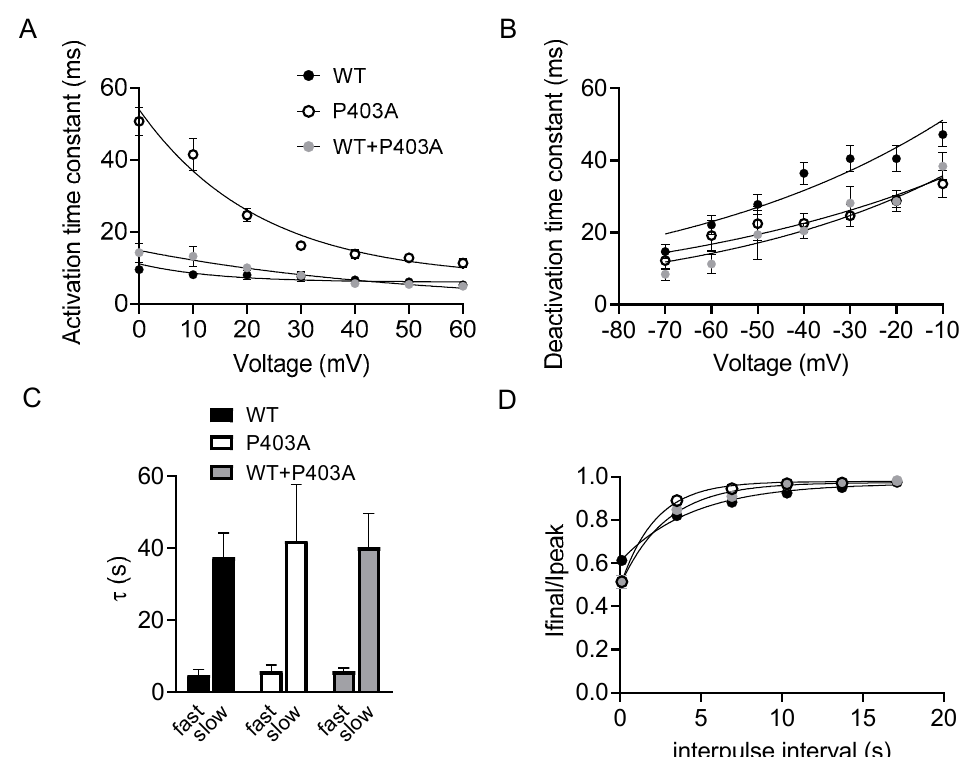
Figure 4. Kinetics of activation ( A ) and deactivation ( B ) measured for Kv1.1 WT, P403A and Kv1.1 WT+P403A channels. The time constants, resulting from the fit of the activating and deactivating current traces with a single exponential function, were plotted as a function of voltage (n = 10–19 cells). ( C ) Bar graphs showing the time constants of the C-type inactivation for the indicated channels calculated by fitting current decay with a single exponential function (n = 9–11 cells). ( D ) Recovery from inactivation for the indicated channels.